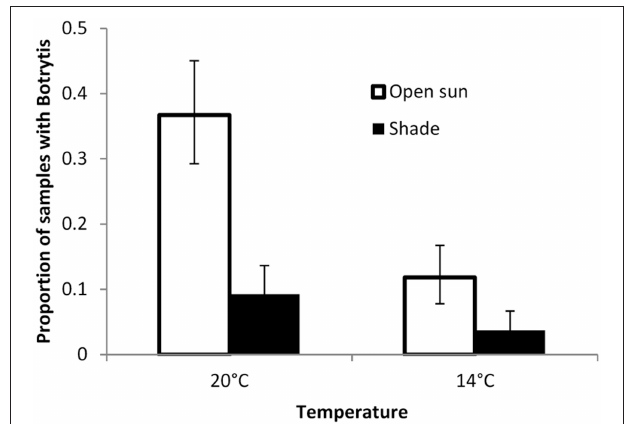
FIGURE 5 | Proportion of samples of lettuce plant tissue from which Botrytis isolates could be recovered after surface sterilization when grown in shaded or open positions in glasshouse conditions. Back-transformed data from anova on square root transformed data. Error bars are 1 SED .